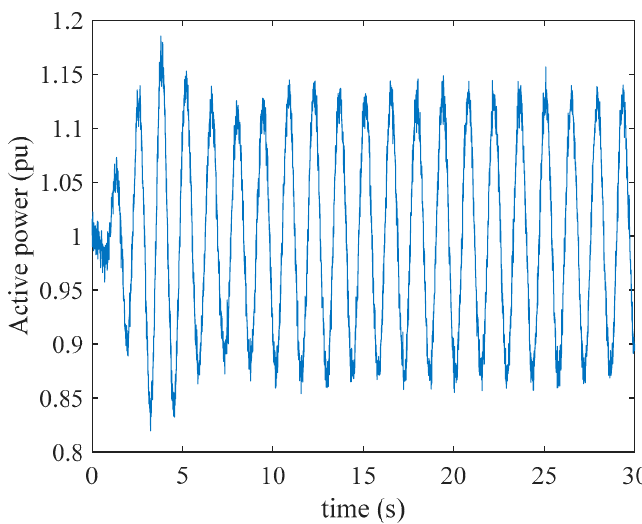
Figure 9. Active power oscillation with the frequency of 0.70 Hz of HXB generator in Shanghai, which is successfully identified as a forced oscillation by the proposed method.